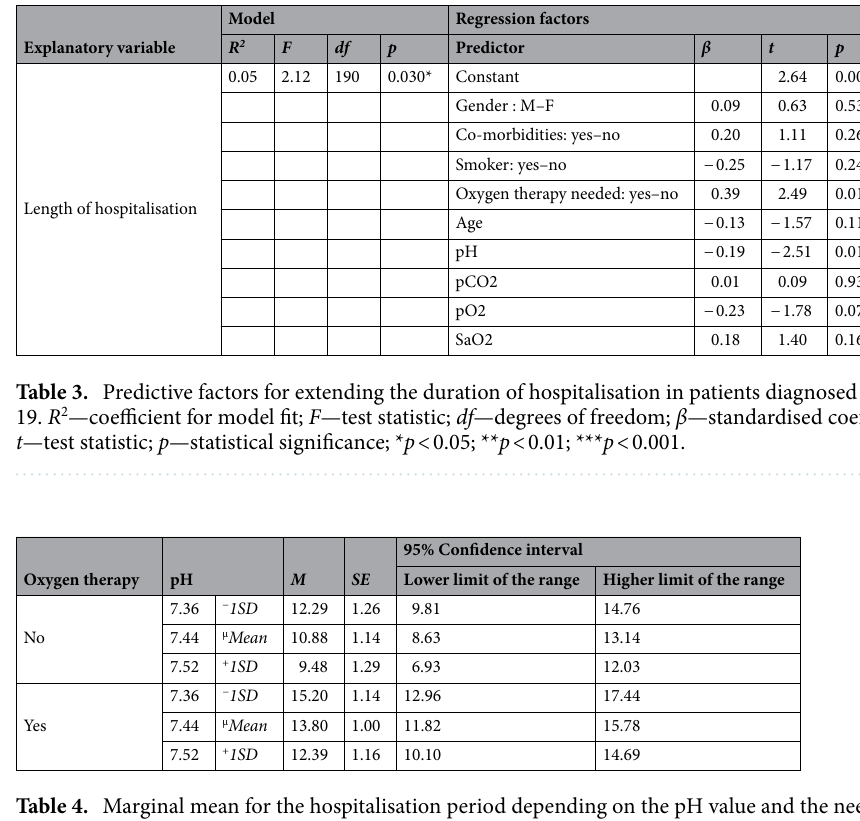
Table 4. Marginal mean for the hospitalisation period depending on the pH value and the need for oxygen therapy. M —mean, SE —standard error, − mean − 1 SD , μ mean, + mean + 1 SD.